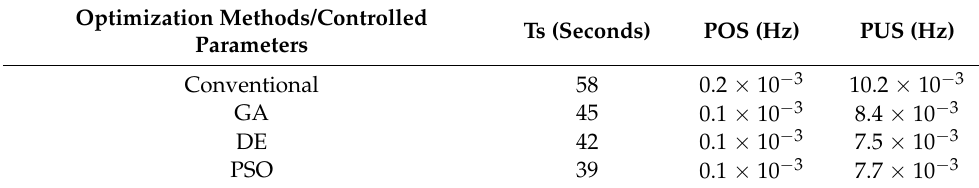
Table 7. Controlled parameters of delF using the ITAE cost function.